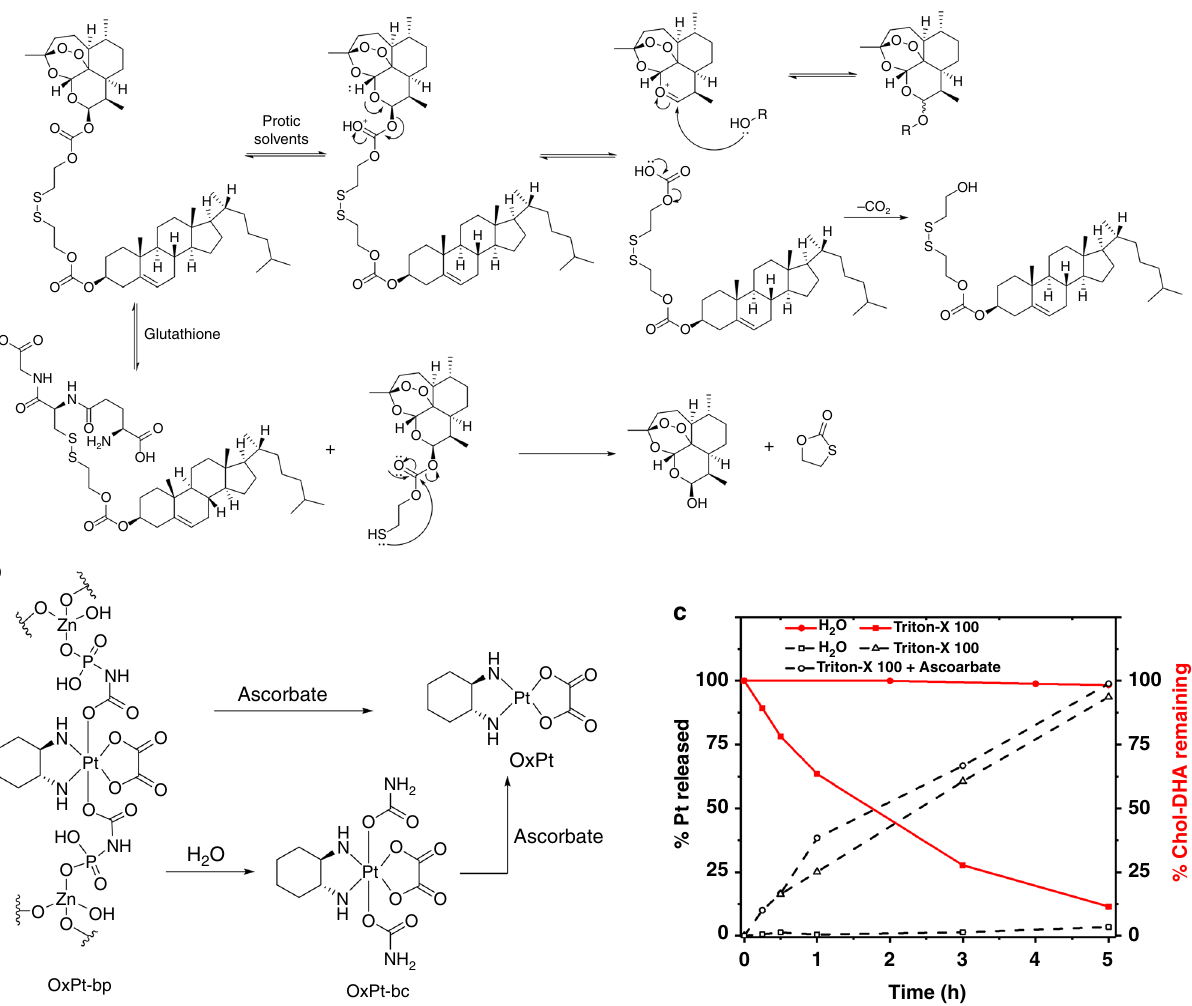
Fig. 3 Release of DHA and OxPt from OxPt/DHA. a Proposed DHA release via GSH-mediated disulphide cleavage and proton-catalysed hydrolysis. b Proposed release of OxPt via direct reduction by ascorbate or a two-step sequence of hydrolysis to generate OxPt-bc followed by reduction to OxPt. c Total Pt release from and chol-DHA remaining in OxPt/DHA particle when incubated in water at 37 °C with or without 0.5% Triton X-100 and 5 mM ascorbate. The data were obtained without repetition. OxPt oxaliplatin, DHA dihydroartemisinin, GSH